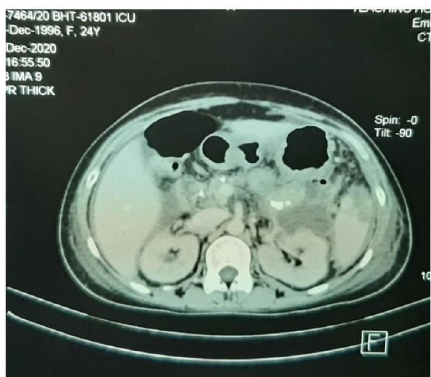
Figure 1: Pancreatic fl uid collection at the tail of the pancreas with gas bubbles seen with in it suggestive of infected pancreatic fl uid